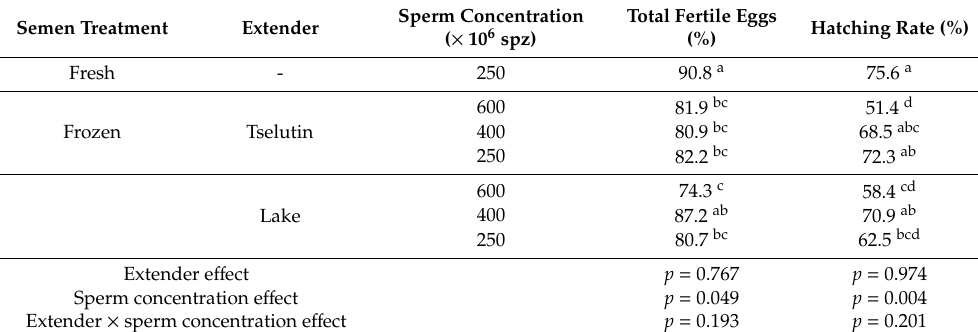
Table 5. Fertility and hatching rates in turkey hens fertilized with fresh and frozen semen in the presence of Lake or Tselutin diluent and three sperm concentrations per insemination